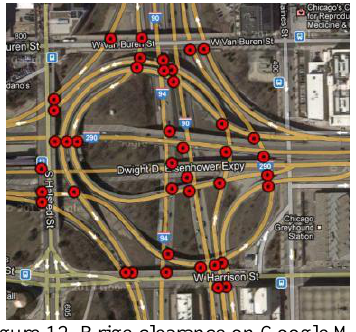
Figure 12. Brige clearance on Google Map